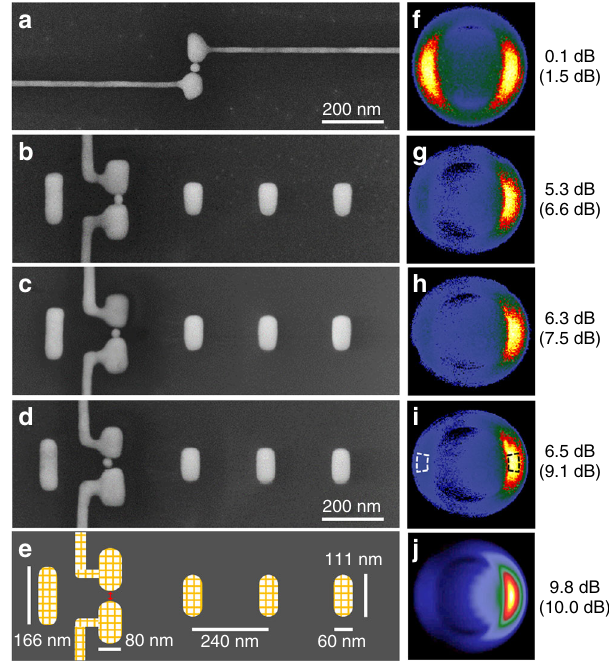
Fig. 3 Comparison of dipole and Yagi-Uda antennas. a – e SEM micrographs of one dipole as well as three Yagi-Uda antennas and a sketch of the FDTD model. f – j Corresponding emission patterns. While the dipole antenna has a balanced emission, the Yagi-Uda antennas show a high directionality to the right (forward direction) and nearly no emission to the left (backward direction). The adjacent numbers give the resulting FB ratios determined by the areal (pixel) method. The integration areas are indicated in i